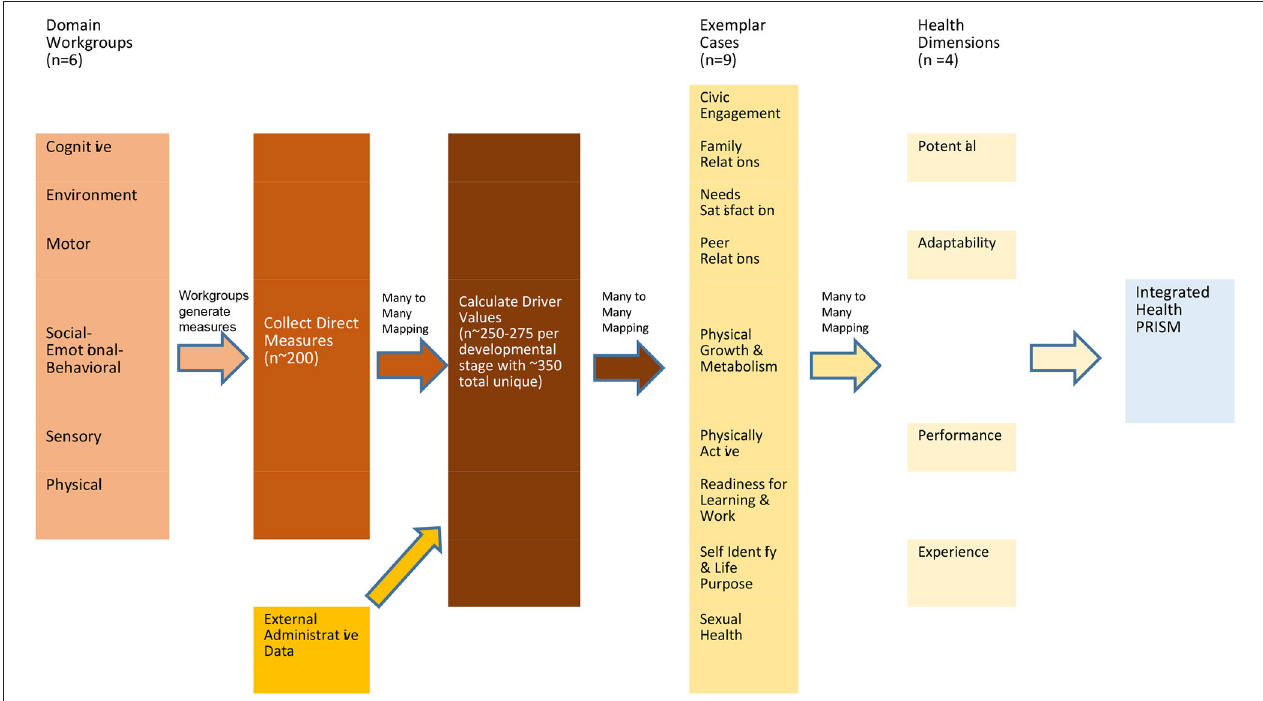
FIGURE 4 | Many to many mapping among system components. The Domain Workgroups propose specific assessments that collectively form a library of direct measures that are age and developmentally appropriate across all six of the assessment domains. From the library of unique assessments, a visit schedule is generated so that each visit is as complete as feasible but not burdensome. The output from the direct assessments is combined with external administrative data and mapped in a series of many to many relationships to the catalog of drivers. Once values are determined for the relevant drivers, those values are subsequently mapped via a many to many process to the Exemplar Cases, which are in turn mapped to four health measurement